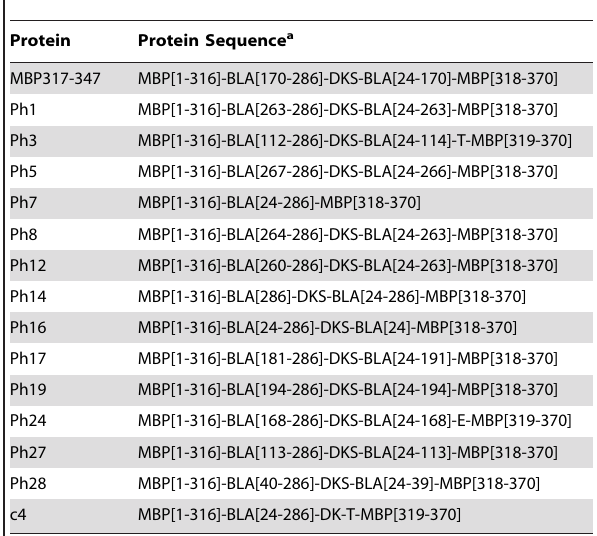
Table 1. Sequence of fusion